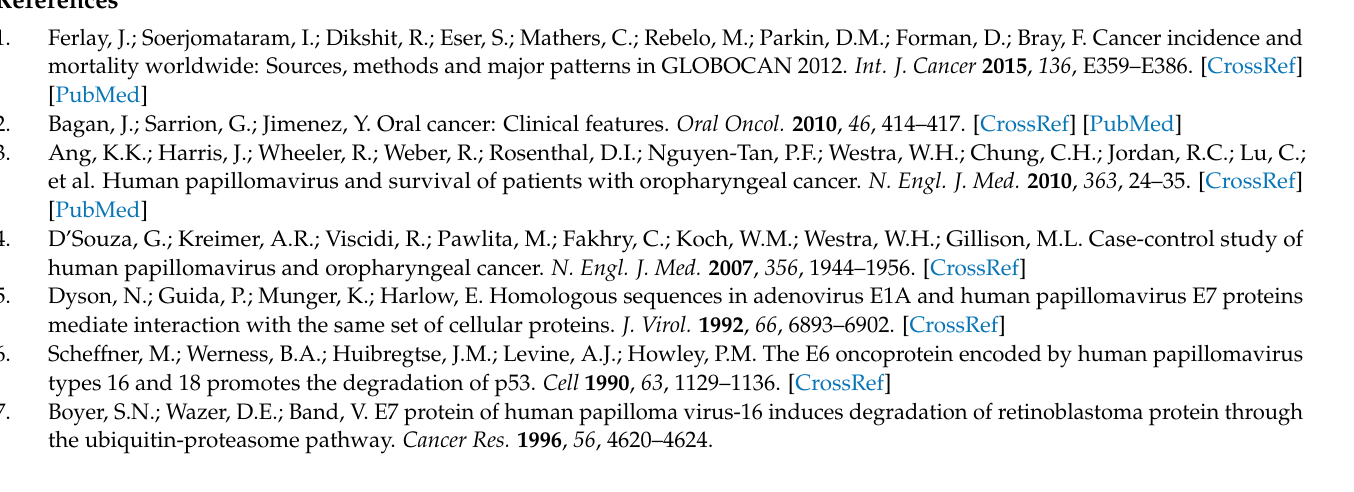
and SCC90. Supplementary Figure S3: Original Western blotting. Supplementary Table S1: Clinico- demographic information of OSCC specimens. Supplementary Table S2: List of human tongue qRT-PCR detection. Supplementary Table S4: The information on antibodies. Supplementary Table S5: Oligonucleotide sequences for shRNAs and